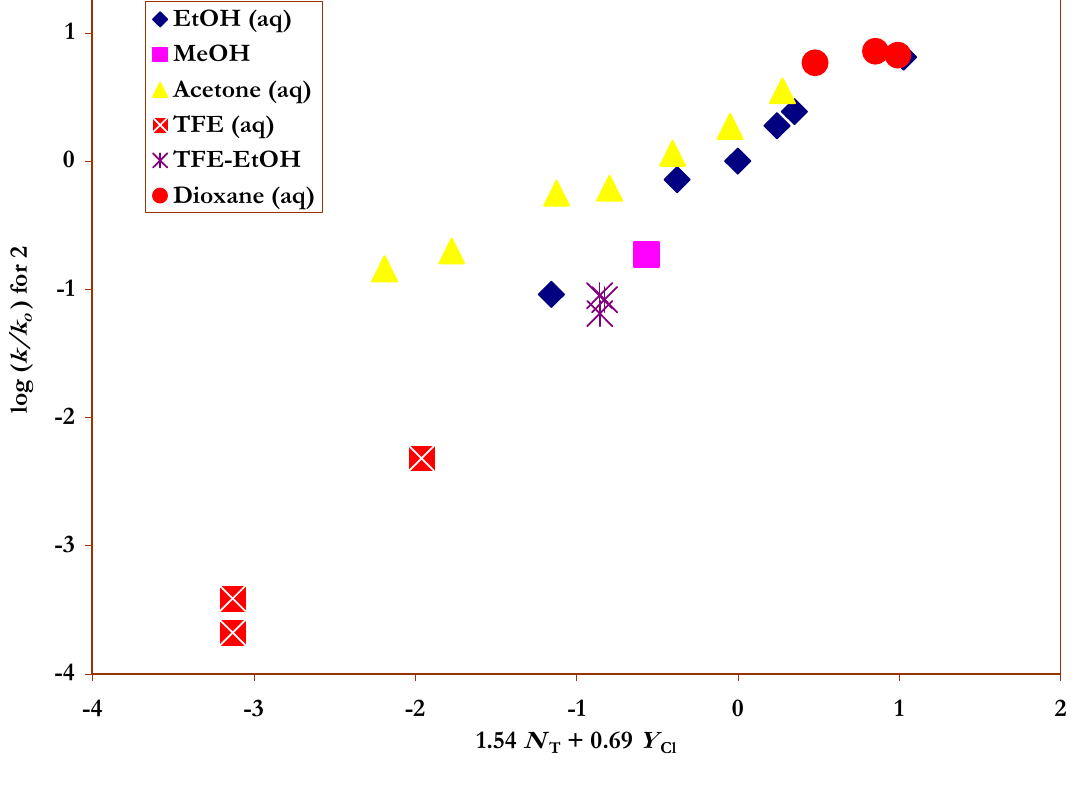
) vs. (1.54 N + 0.69 Y ) for the solvolyses of p -nitro- o T Cl